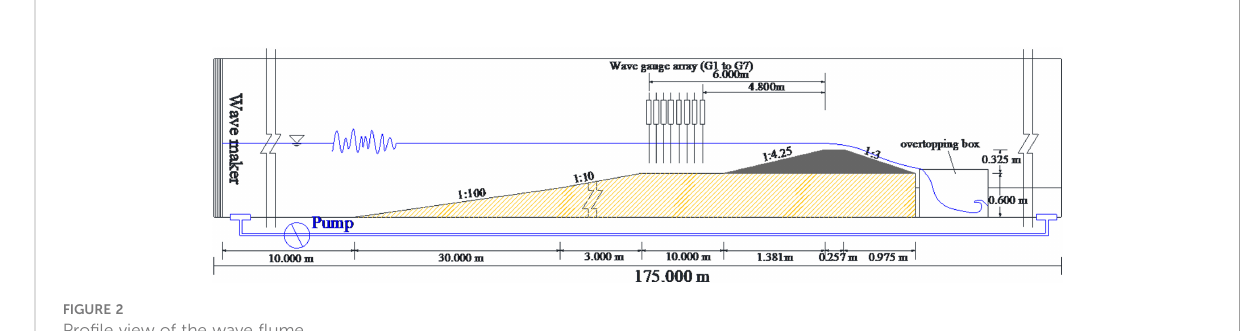
FIGURE 2 Pro fi le view of the wave fl